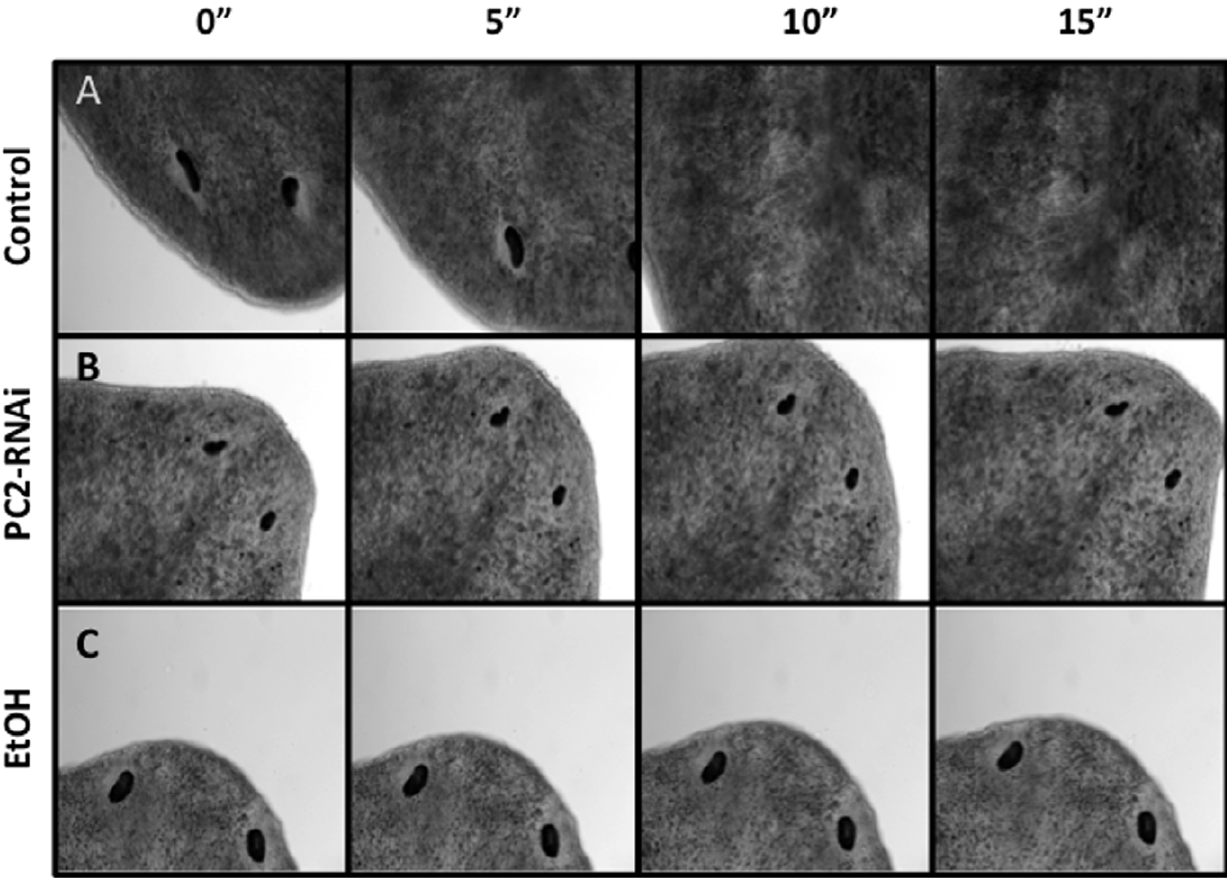
Figure 3. A 3% Ethanol Treatment Inhibits Fine Movements. Analysis of Fine Movements (body movements while stationary) . Time lapse images of worms taken over 15 seconds, highlighting the need for immobilization of live planarians when imaging. ( A ) Untreated control worm moved its head completely out of frame in less than 10 seconds. ( B ) A PC2-RNAi injected worm (without gross movements) remained in frame; however fine movements were not inhibited, as seen by its head progressively extending across the frame. ( C ) An EtOH-treated worm stayed completely in frame without any fine movements. (The assay required loose mounting, resulting fluid drift, but note that the eye/body positions remain the same).